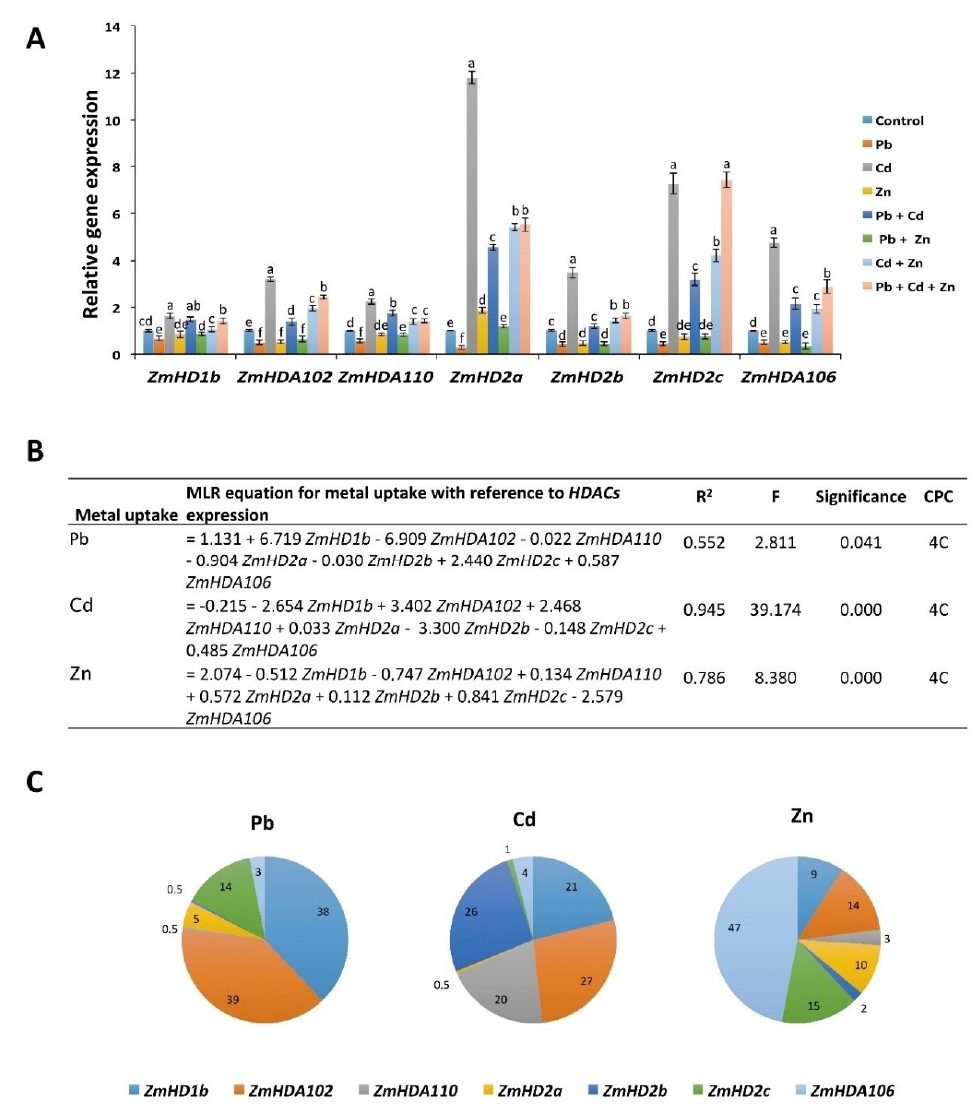
Figure 4. The expression of histone deacetylases in response to Pb / Cd / Zn applied alone and in combinations. ( A ) The expression of histone deacetylases was normalized with ZmUBQ5 . The data presented are the averages of three biological replicates. Bars represent mean ± SD. The values marked with di ff erent letters are statistically di ff erent ( p ≤ 0.05), while the values marked with the same letters do not di ff er significantly. ( B ) Multiple linear regression (MLR) equations for uptake of each heavy metal and expression of HDACs . ( C ) Cumulative percentage contribution (CPC) for expression of each HDAC transporter in response to the uptake of heavy